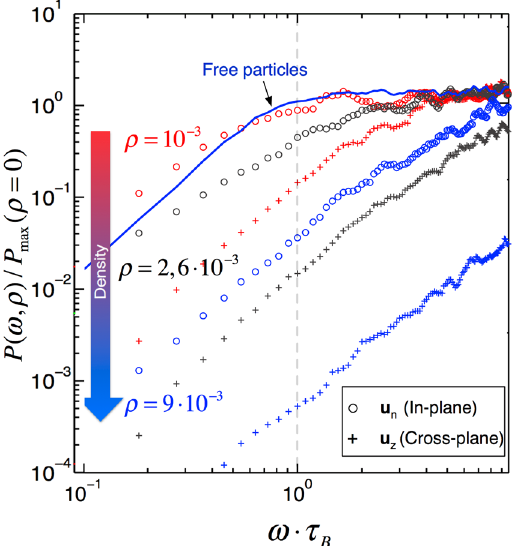
Figure 4. Influence of the dipole density on the power dissipated. Spectra of power dissipated at low ( ρ = 10 − 3 nm − 2 ), medium ( ρ = 2.6 · 10 − 3 nm − 2 ) and high density ( ρ = 9.10 − 3 nm − 2 ), normalized by the maximum of power dissipated for noninteracting MNPs as a function of the frequency of the external field. The solid blue line corresponds to noninteracting MNPs. The maximum dissipated power is dramatically reduced by the interactions. For the sake of clarity, only the dominant in-plane and the cross-plane components are